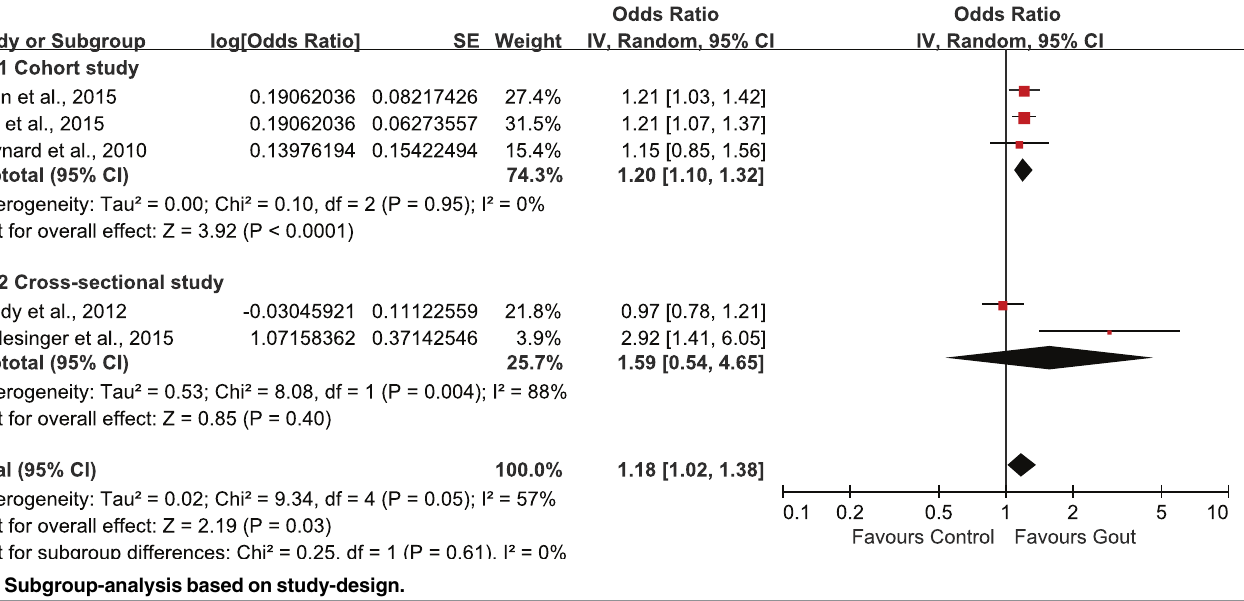
Fig 6. Subgroup-analysis based on study-design.